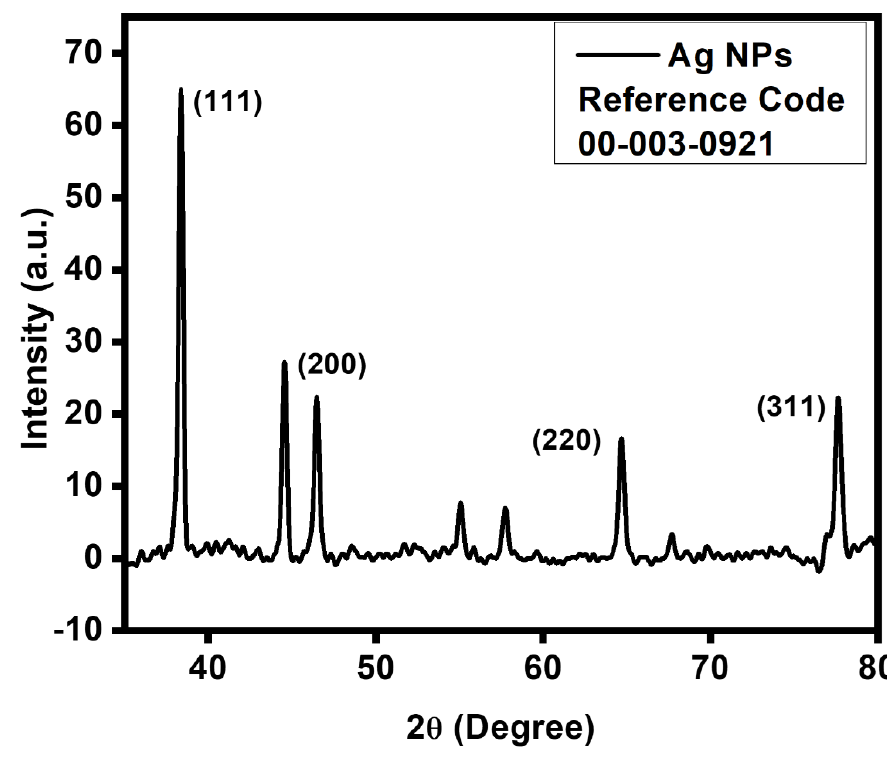
Figure 4. XRD pattern of biogenic Ag NPs.